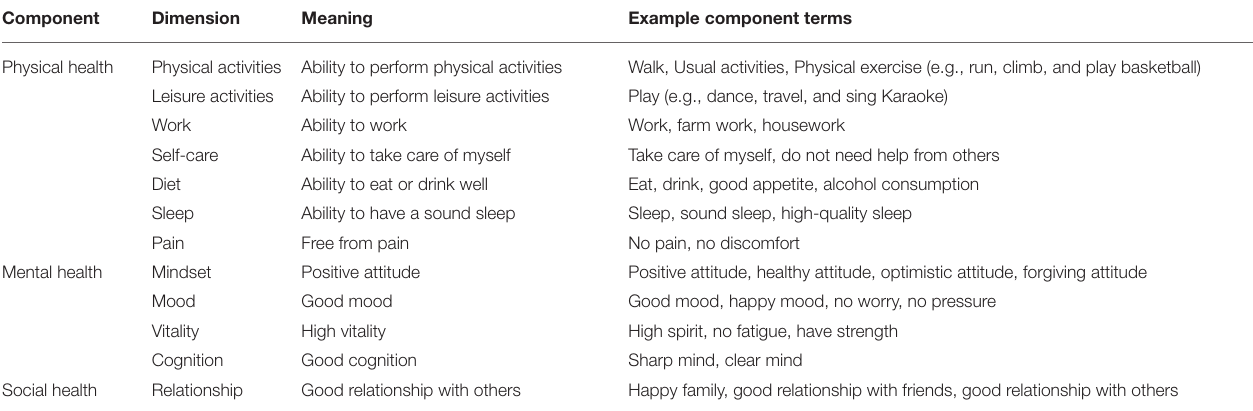
TABLE 1 | Identified health dimensions from healthy persons and patients.